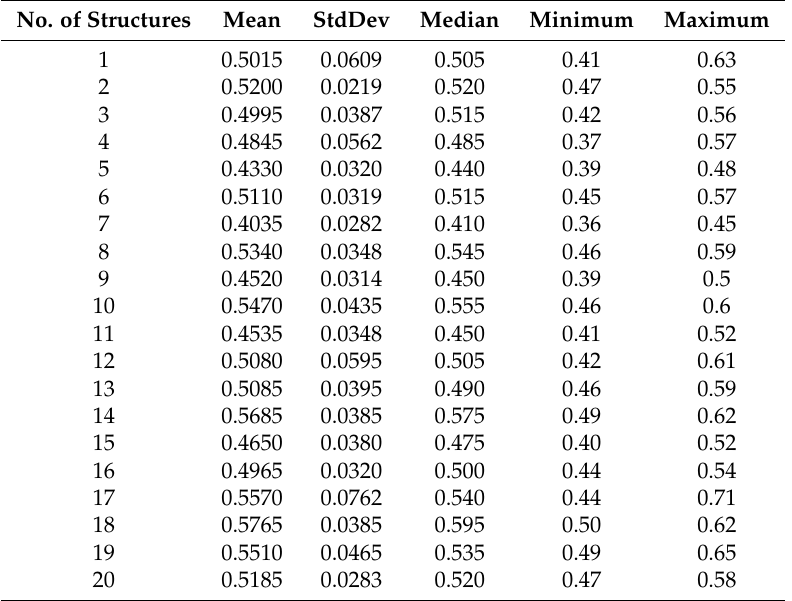
Table 7. Classification error rate (in %) of the 20 best solutions (CNN architectures) of the MBO algorithm. No. of Structures